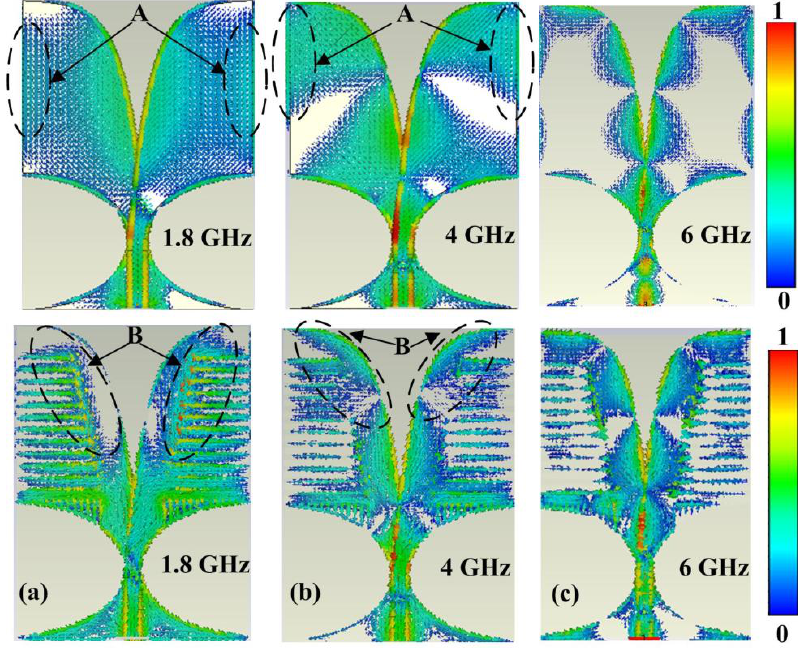
Figure 5. Surface current distributions of Structure C ( a ) at 1.8 GHz, ( b ) 4 GHz, and ( c ) at 6 GHz.